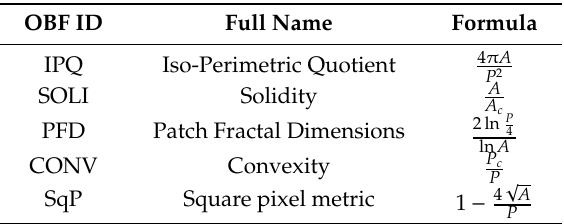
Table 3. Object-based features (OBFs) that were used in this research ( A and P : area and perimeter of the features; A c and P c : area and perimeter of the convex hull of the